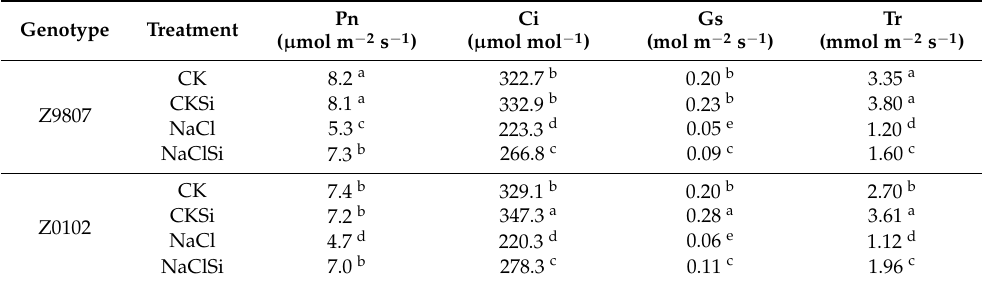
Table 1. Effect of exogenous Si on gas-exchange parameters of cotton leaf under saline and non-saline conditions.